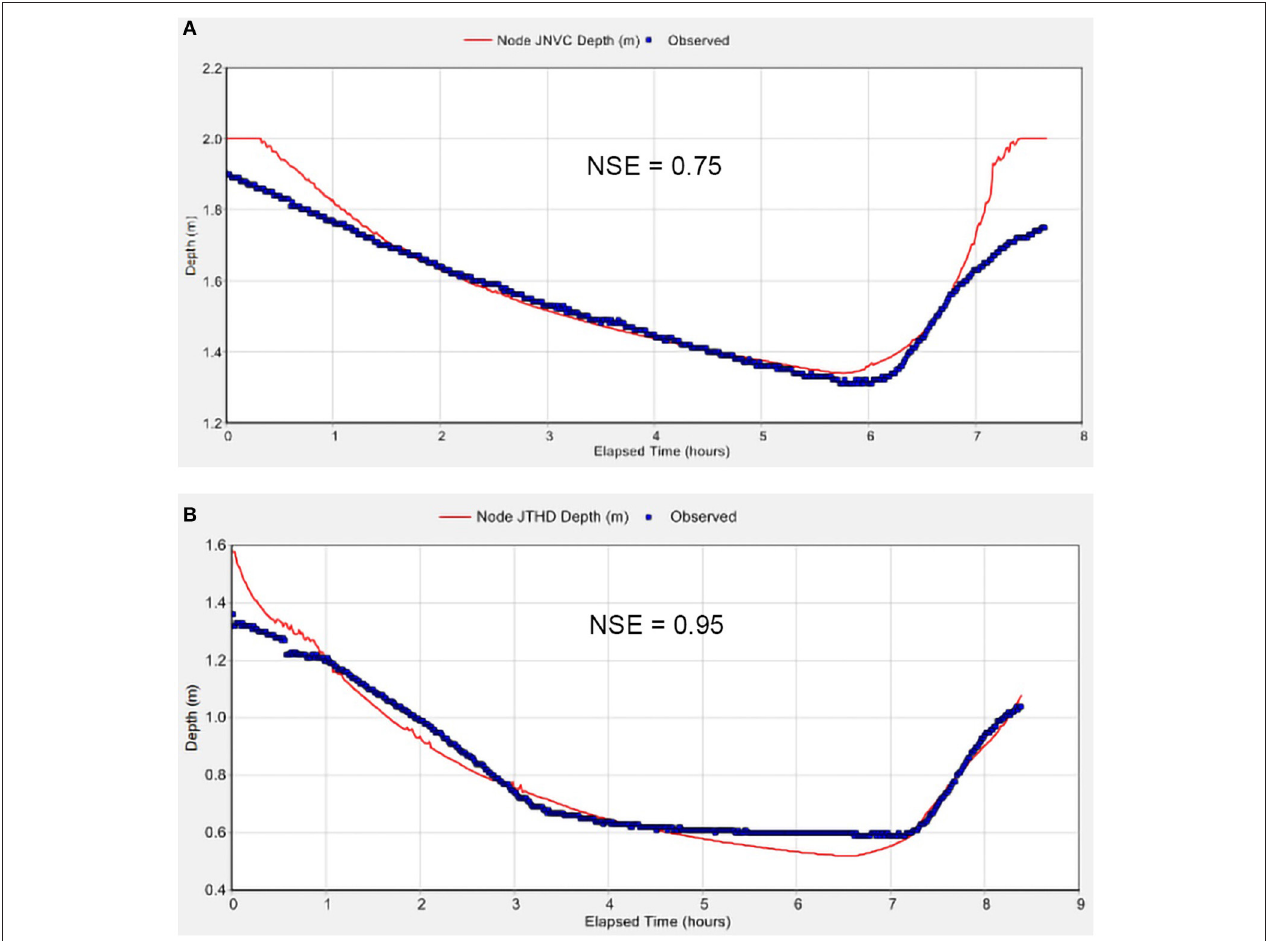
FIGURE 7 | Comparison between simulated and observed water depths in the manholes at Nguyen Van Cu (A) and Tran Hung Dao (B) streets on October 17,